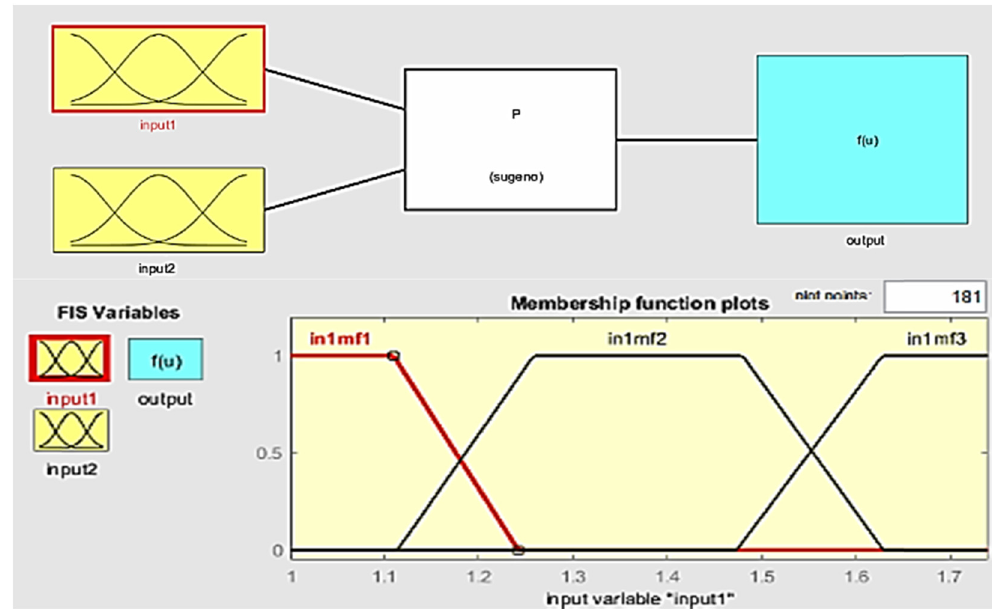
Figure 5: The input and output parameters in the ANFIS model.